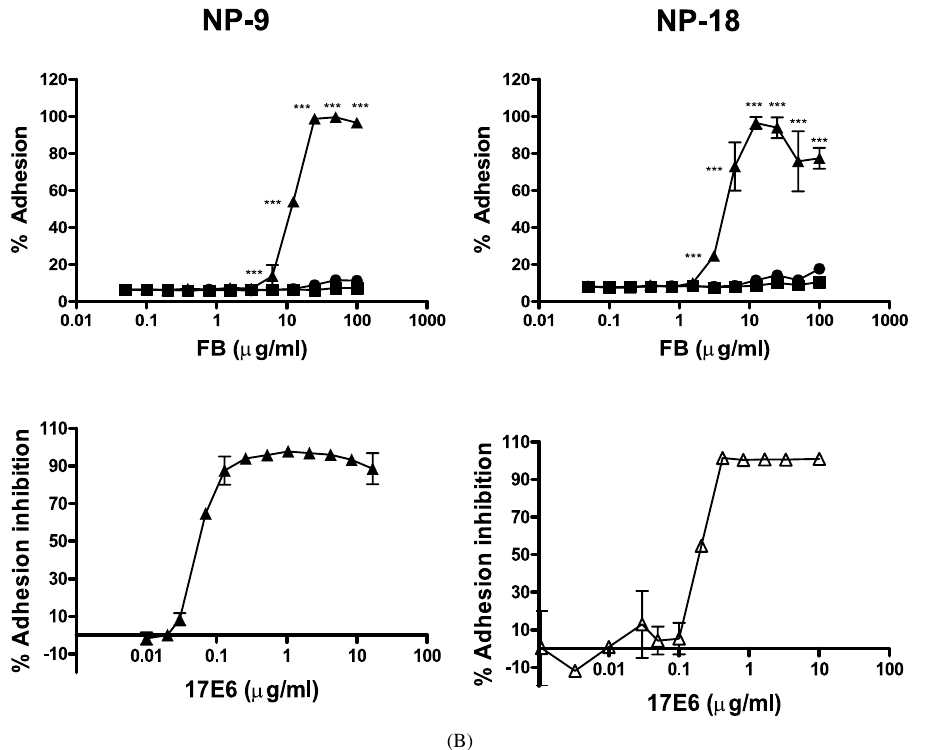
Fig. 3. (B) Fibrinogen (FB). For adhesion assays, results are expressed as % of the maximum OD value of crystal violet-stained cells, working with sample triplicates in each experiment ( n = 3). Symbols: ( " ) wt; ( (cid:3) ) mock and ( Q ) β 3 -transfected. For adhesion inhibition assays, purified 17E6 mAb was co-incubated during cell attachment to fibrinogen-coated substrate. Symbols: ( Δ ) NP-9 β 3 and ( Q ) NP-18 β 3 . In all cases, means ± SD are shown. Statistics: 2-way ANOVA, * p < 0 . 05, ** p (cid:2) 0 . 01, *** p (cid:2) 0 . 001 vs. wt or